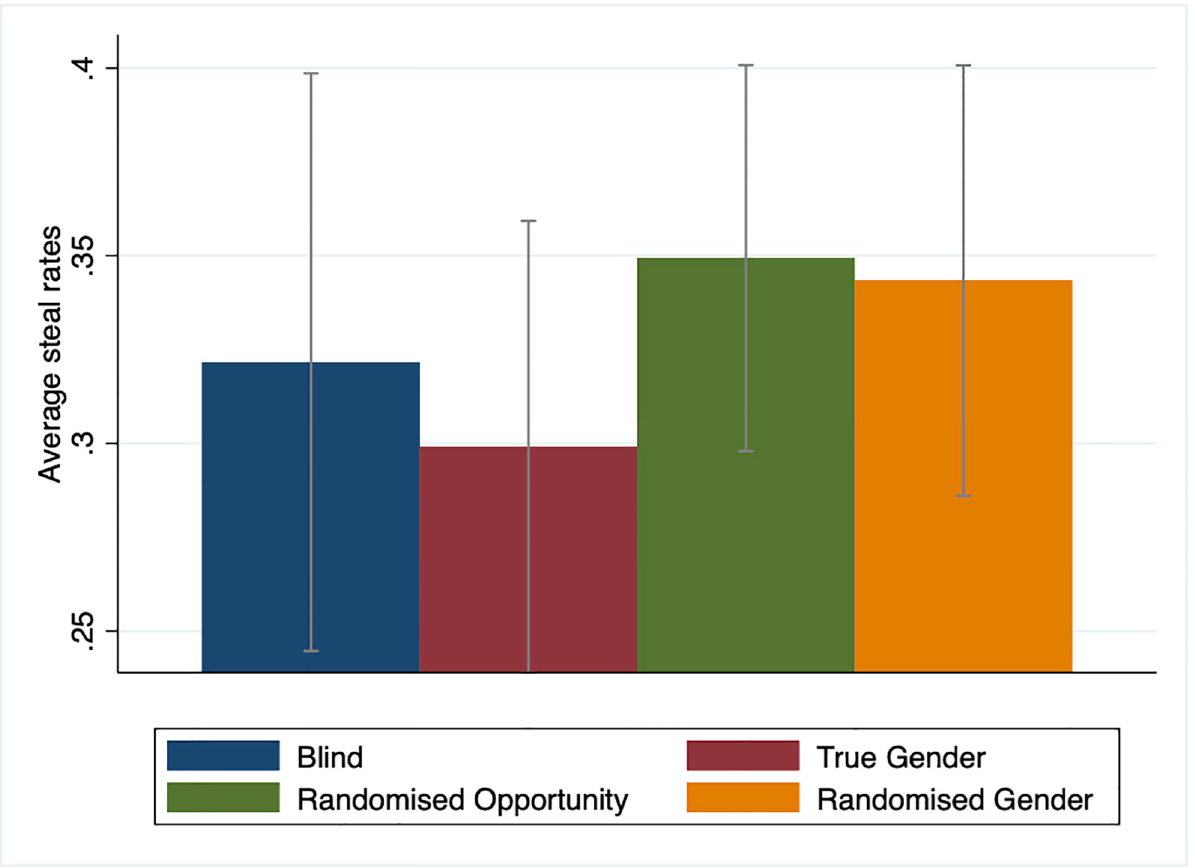
Fig 2. Average steal rates in the Golden Balls game by treatment. Blind treatment = information on each participant’s gender is not revealed; True gender = information on each participant’s gender is revealed to each other in a pair; Randomised opportunity = one participant in each pair is randomly allocated an opportunity to misrepresent their gender, whilst the other participant is told that the other person may or may not be misrepresenting their gender; Randomised gender = one participant in a pair is randomly allocated a gender, which may or may not match their true gender. Error bars represent 95% confidence